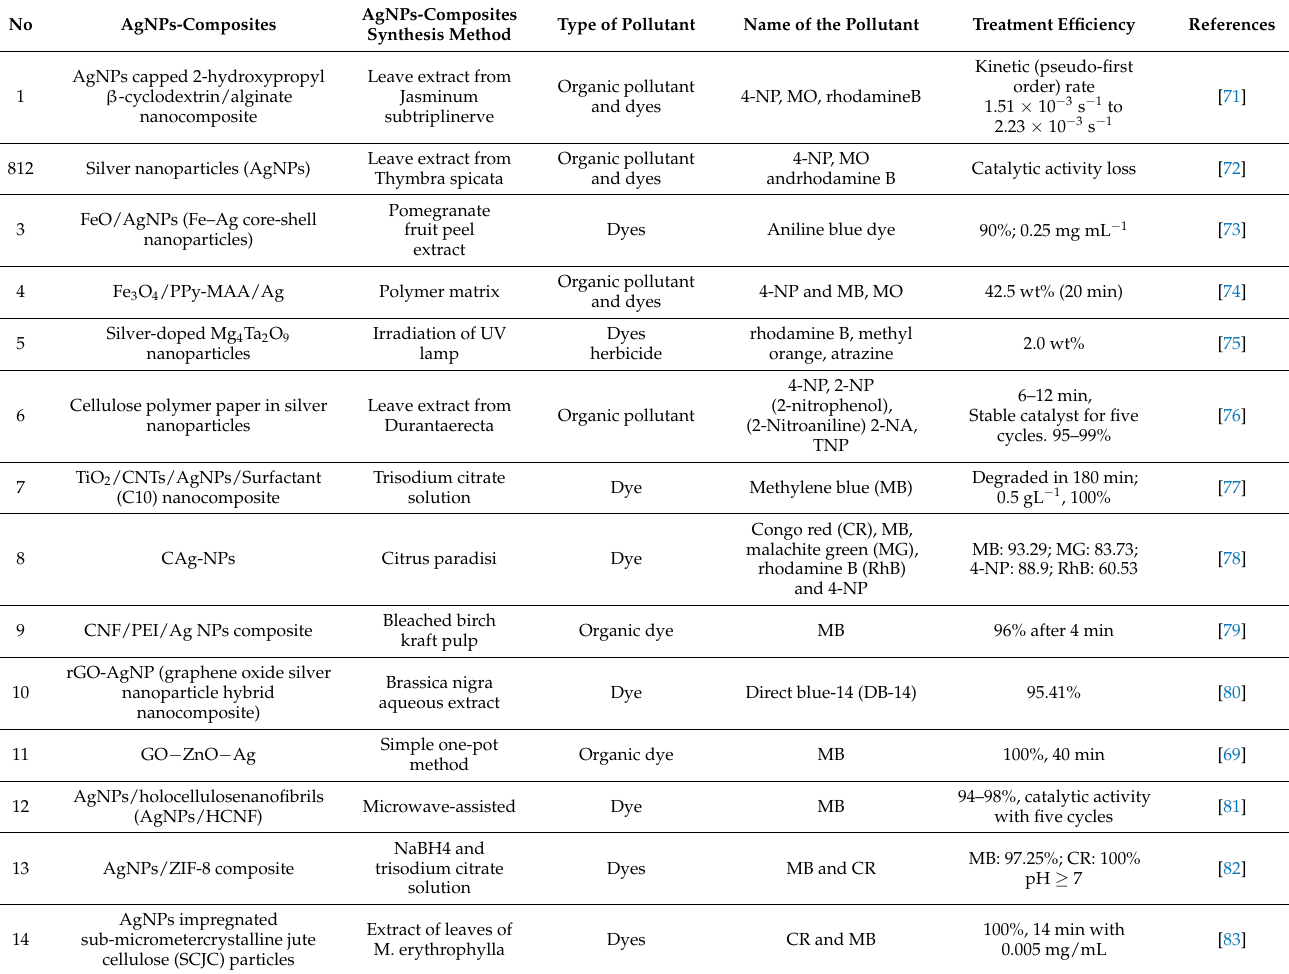
Table 2. Sliver nanoparticles for dye